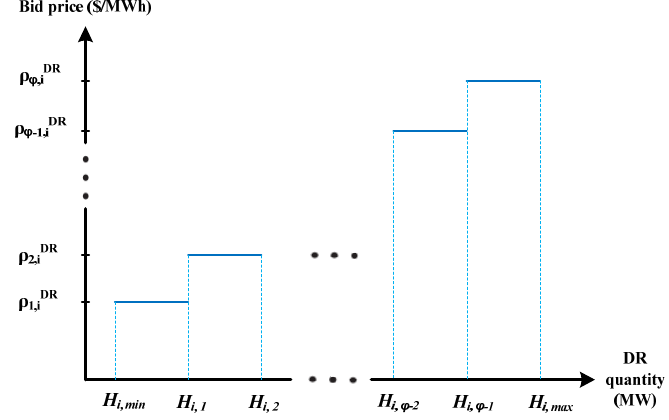
Figure 2. A bid-quantity offer package for i th node.